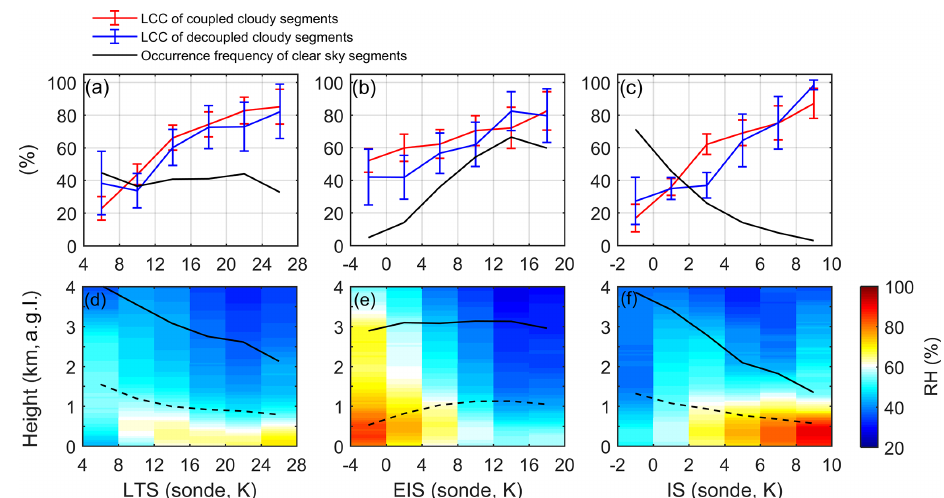
Figure 3. (a–c) LCC composites of the coupled cloudy (red line) and decoupled cloudy segments (blue line) and the occurrence frequency of the clear-sky segments (black line). (d–f) Composited RH profiles. Composites are based on the SGP radiosonde-measured LTS ( a and d ), EIS ( b , and e ) and IS ( c and f ), respectively. Error bars in (a–c) show the 95% confidence interval of the mean based on the t test. The solid and dashed black lines in (d–f) indicate the average height of the inversion center and the LCL, respectively. All composites are based on daily data of all seasons for the full period at the SGP.